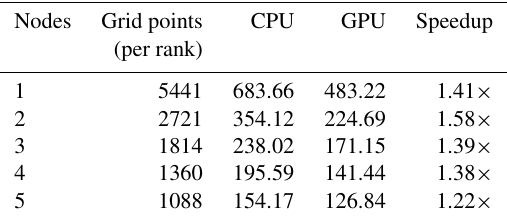
Table 4. The speedup of multiple nodes for the 228K mesh size on Summit. We used all 42CPU cores and 6GPU on each node with a configuration of 7 MPI ranks per GPU.